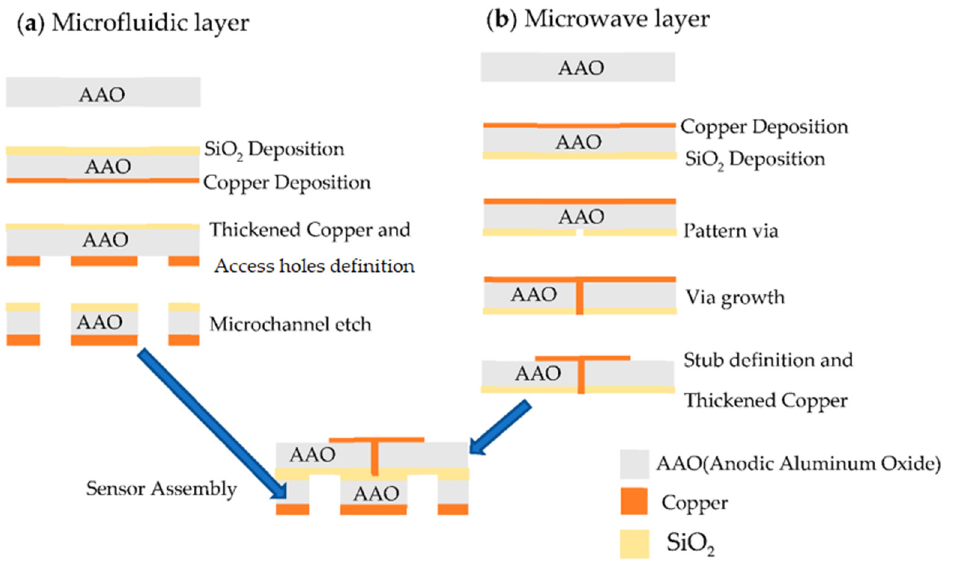
Figure 5. Fabrication steps of the microfluidic and microwave layers for our proposed biosensor.